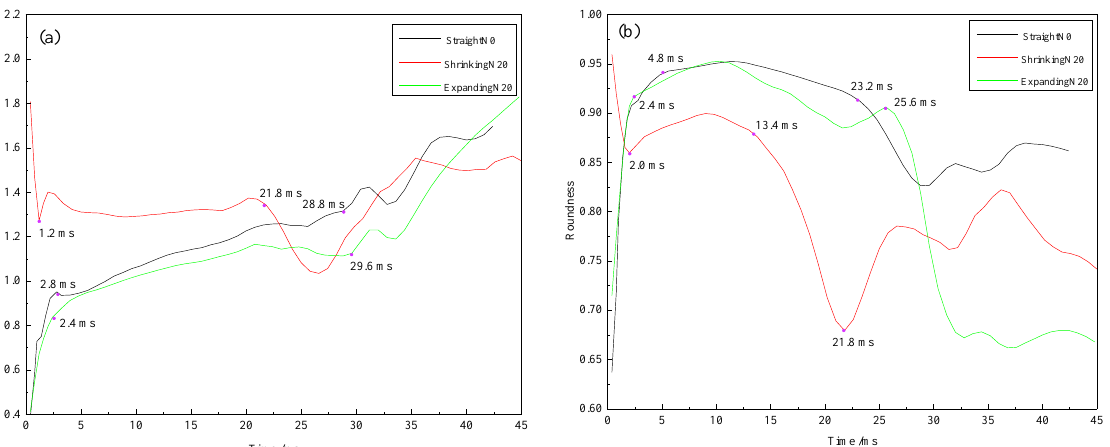
Figure 12. Curves of the aspect ratio and roundness of the bubbles when different nozzles were installed. ( a ) Curves of the bubble L/W when different nozzles were installed, ( b ) Curves of the bubble roundness when different nozzles were installed.